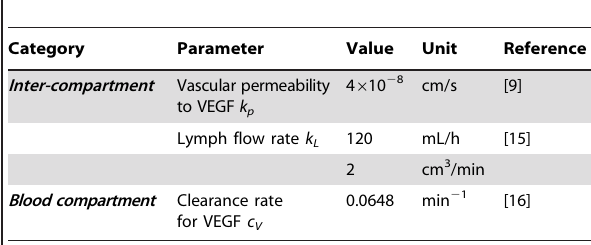
Table 5. Kinetic parameters between the compartments and in the